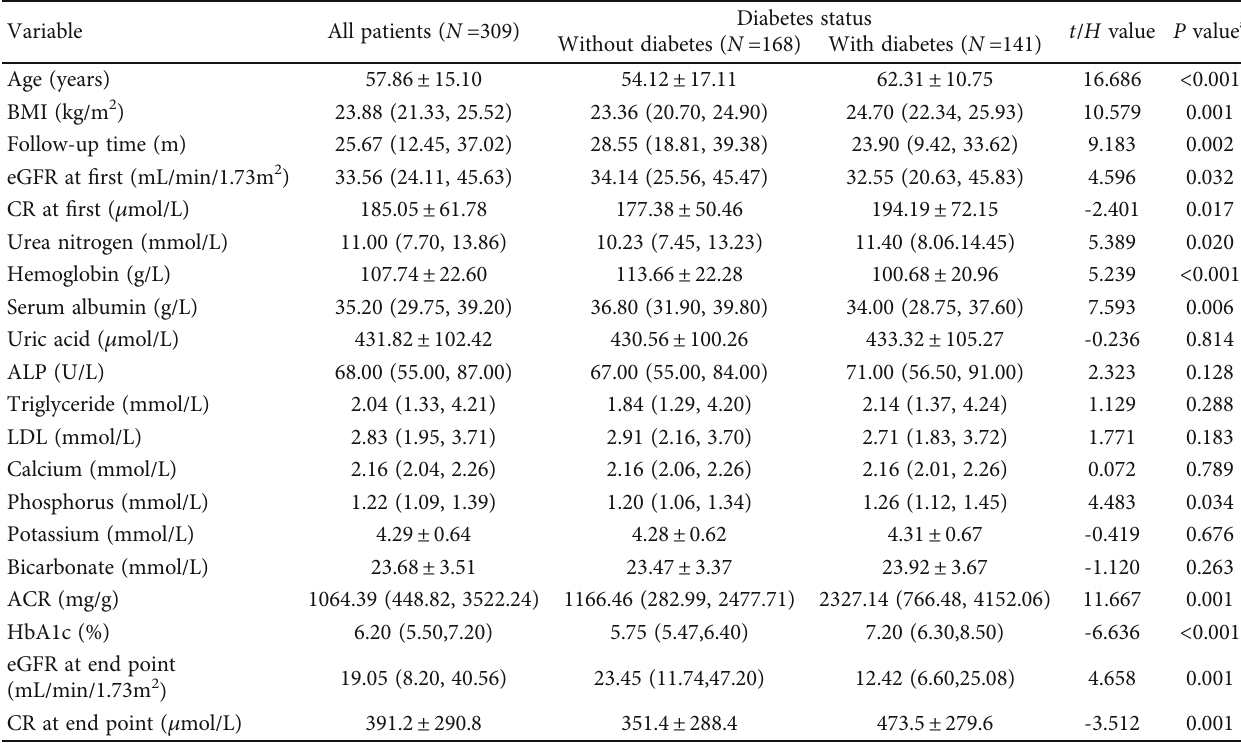
Table 1: Basic clinical characteristics of all patients and diabetic patients.